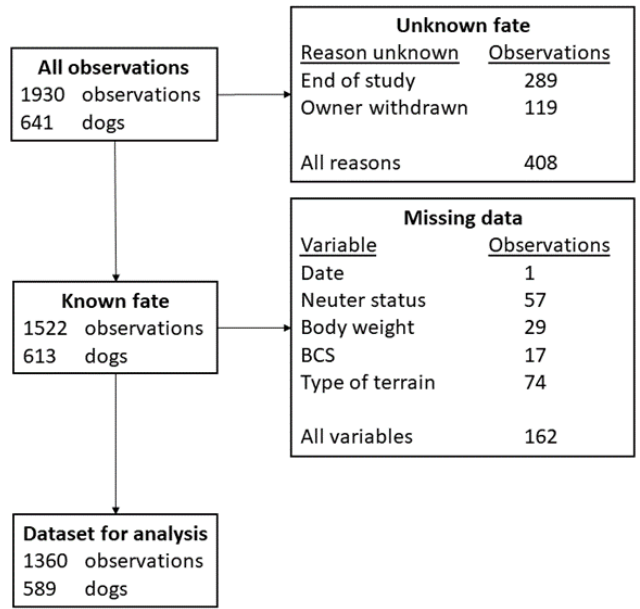
Figure 2. Flowchart showing the number of examinations that were removed from the analysis due to missing information. As examinations could have missing data in more than one variable, the sum of examinations with missing data in the different variables do not equal the total number of examinations that were removed. Note that dogs that had one or more examinations removed could still be present in the